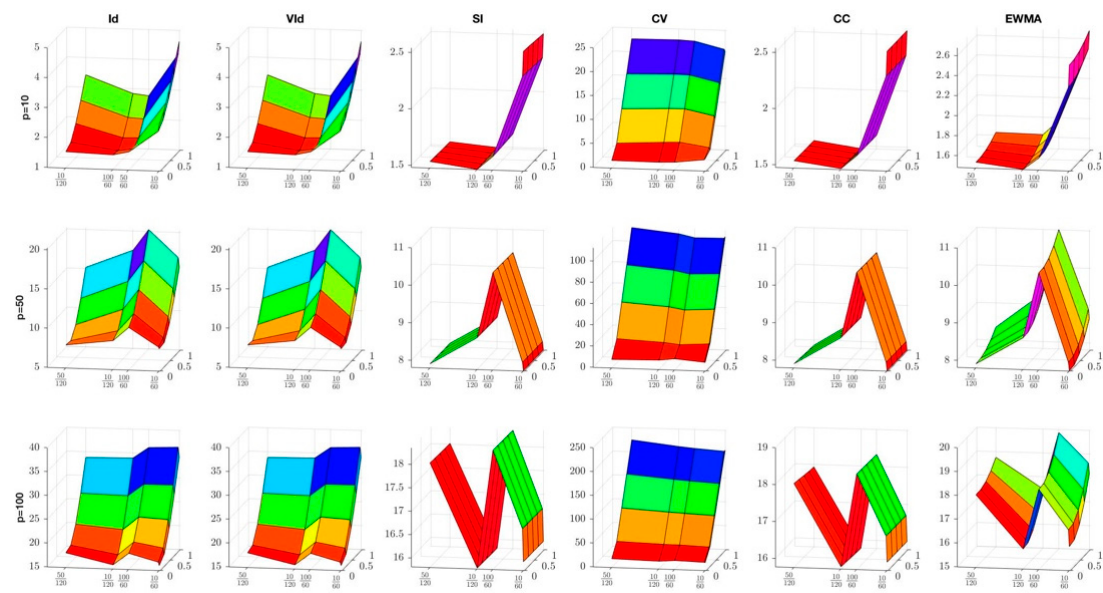
Figure 3. Surfaces representing the Frobenius norm (z-axis) between the true and the estimated target matrices, considering the shrinkage intensity (y-axis) and the p / n ratio (x-axis). Each column corresponds to a specific target matrix: from left to right, the Identity (Id), the Variance Identity (VId), the Single-Index (SI), the Common Covariance (CV), the Constant Correlation (CC), and the EWMA, respectively. Each row corresponds to a different p : in ascendant order from p = 10 (first row) to p = 100 (third row).